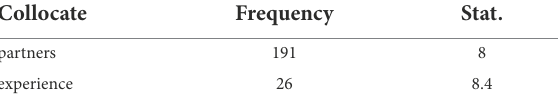
TABLE 8 Most Frequent collocates that predicate the customers.